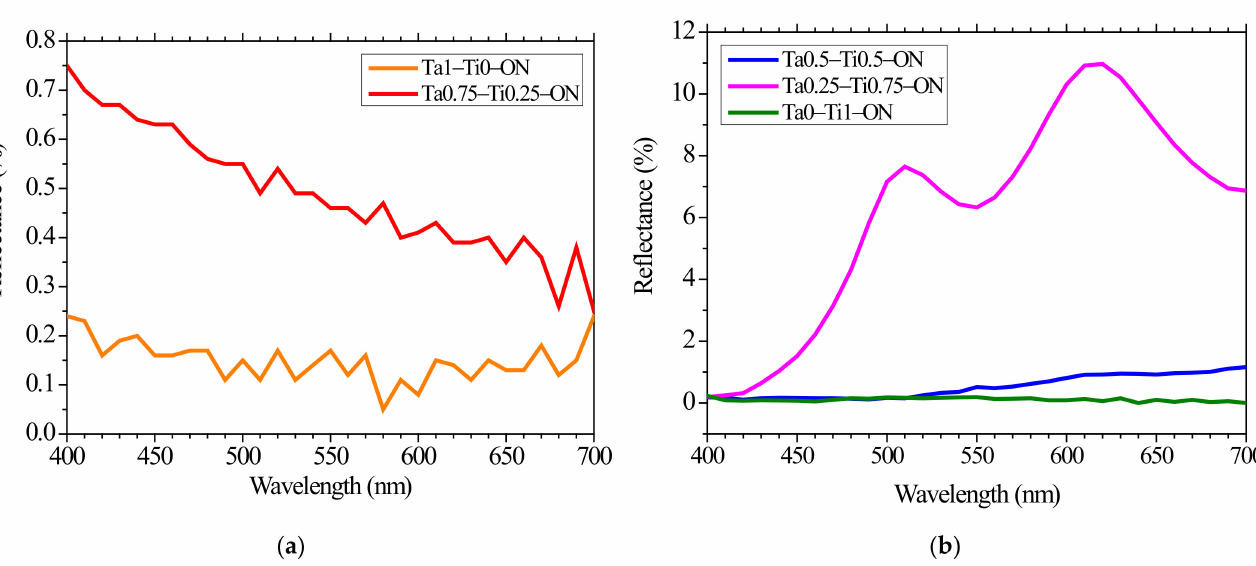
Figure 11. The variation of the colour coordinates in the CIE L*a*b* colour space. The remaining three films exhibit large differences among them. It must be mentioned that these changes are not related only with the interaction with visible radiation with the film surface. The relatively high O content promotes the formation of oxides, which are generally transparent to visible light, as it is the case of TiO 2 . Because of this transparency, the colour parameters are resultant not only from the intrinsic colour of the film but also from what it is below the surface, substrate included. These observations can be confirmed by the diffuse reflectance spectra of the samples (Figure 12a,b).